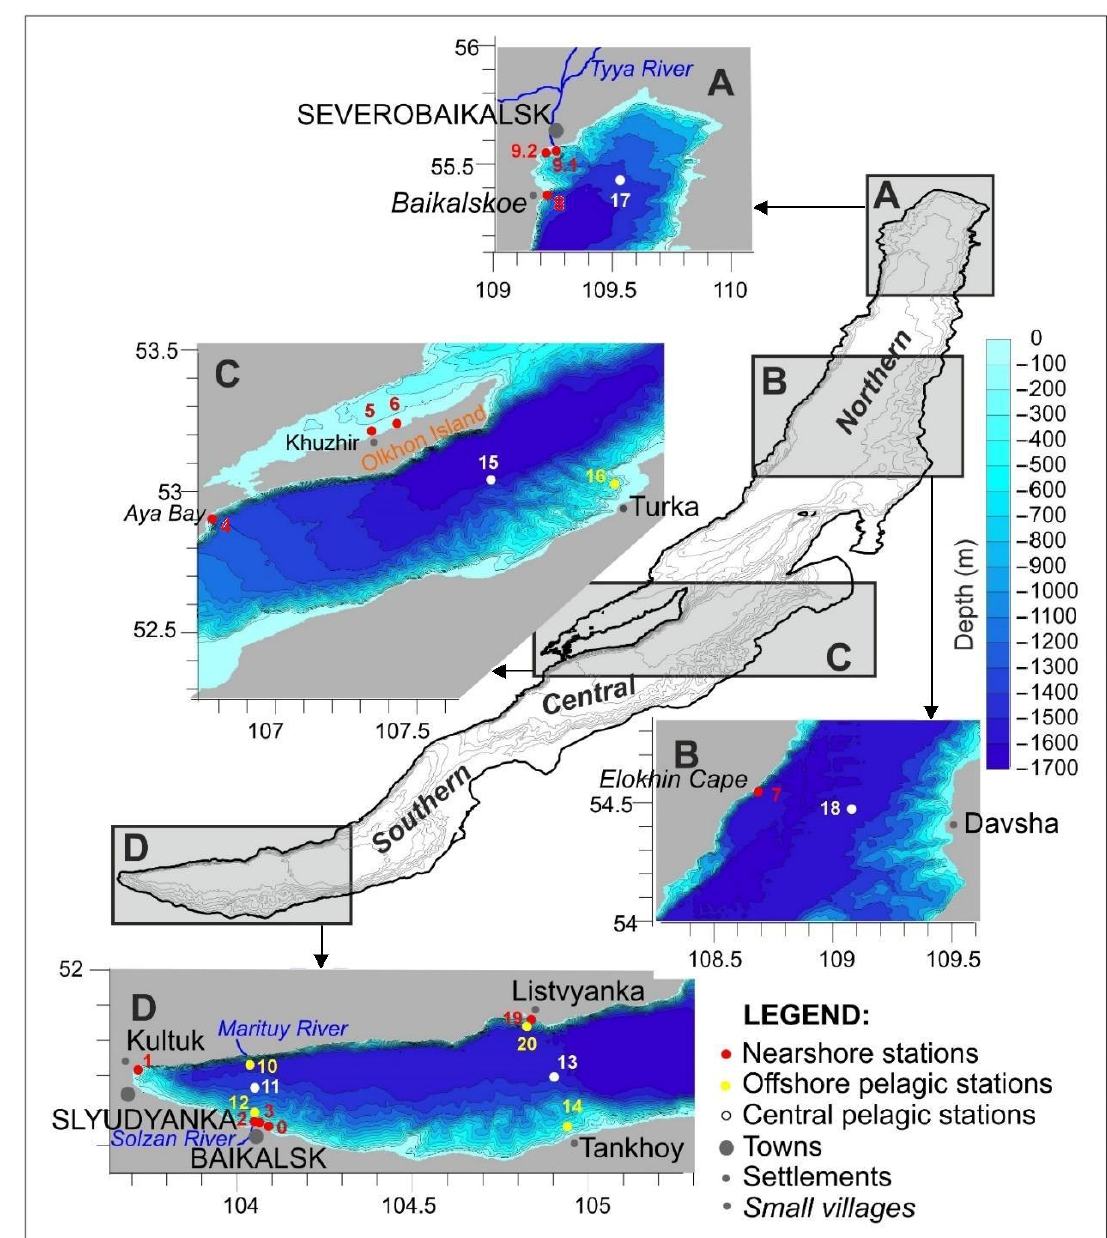
Figure 1. Bathymetric map of Lake Baikal. Sampling sites are marked.